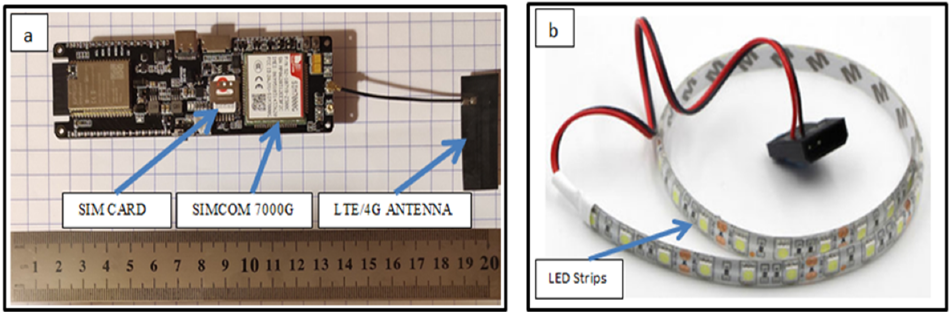
Figure 7. ( a ) Low-cost 4G/LTE module; ( b ) Digital LED strips.